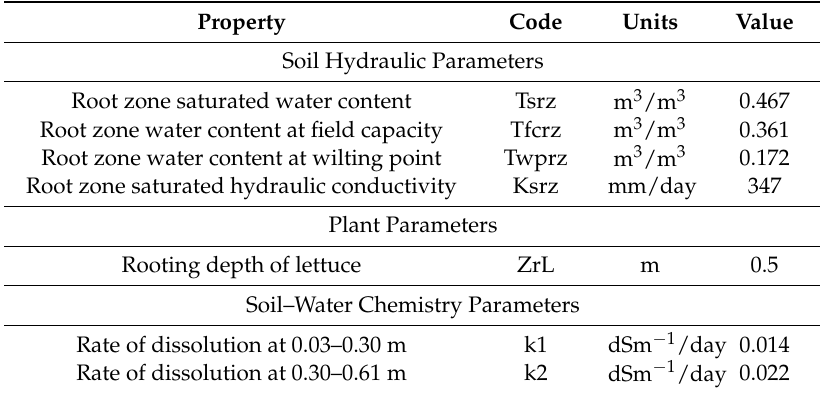
Table 7. Best-fit parameter values estimated with calibration for EC sw